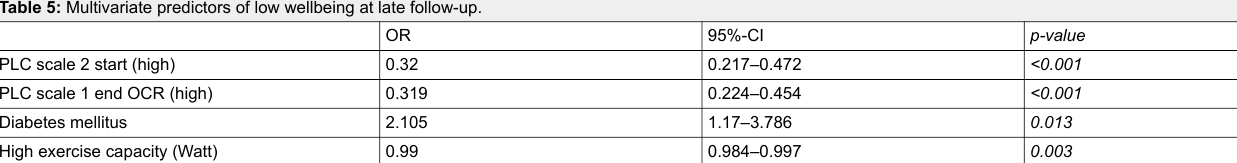
Table 5: Multivariate predictors of low wellbeing at late